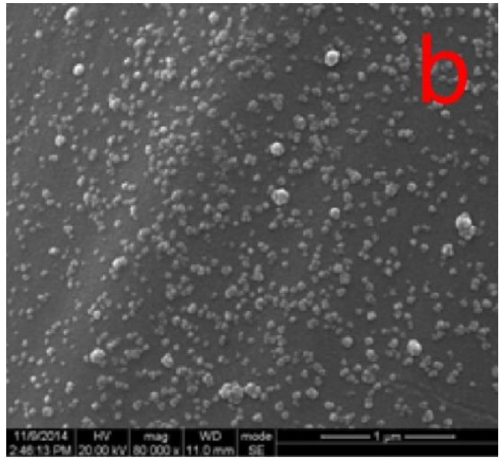
Figure 11. Chain cleavage products on PBIA fiber surface after direct fluorination [123]. Reprinted with permission from ref. [123]. Copyright 2016